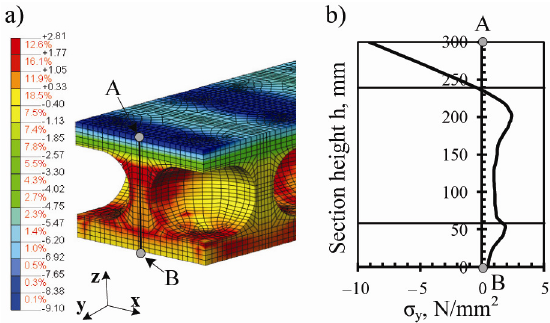
Fig. 12. Stress distribution in the concrete of the slab cross- section, point 1A: a) overall image; b) graphic image